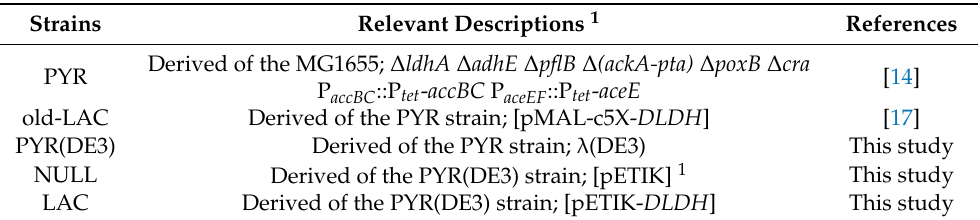
Table 1. E. coli strains used in this